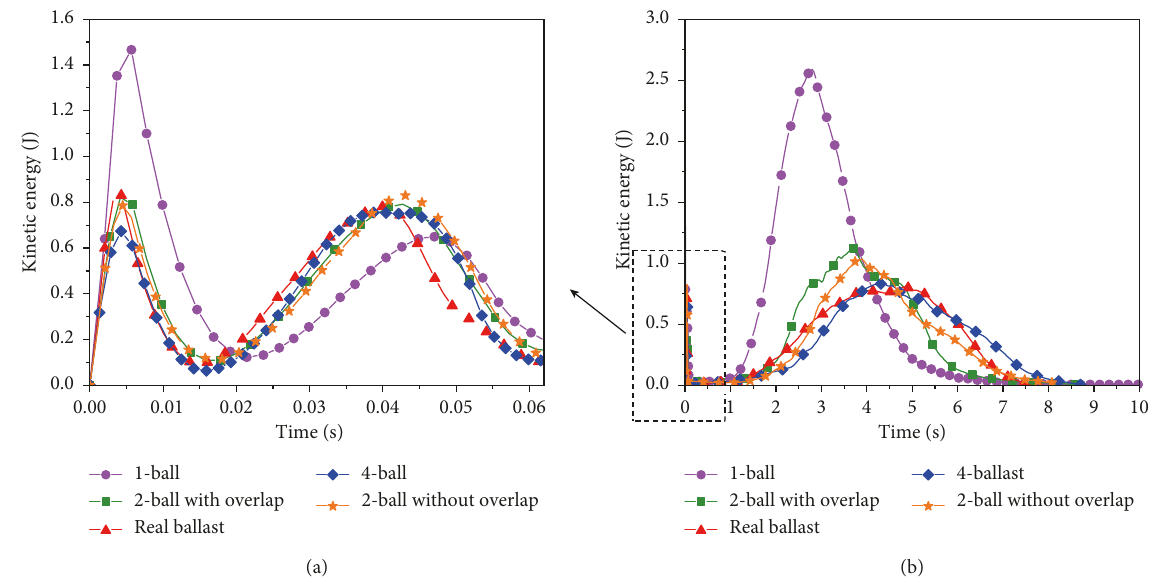
Figure 18: The kinetic energy variation of particle assemblies for five models. (a) 0–0.062s; (b) 0–10s.